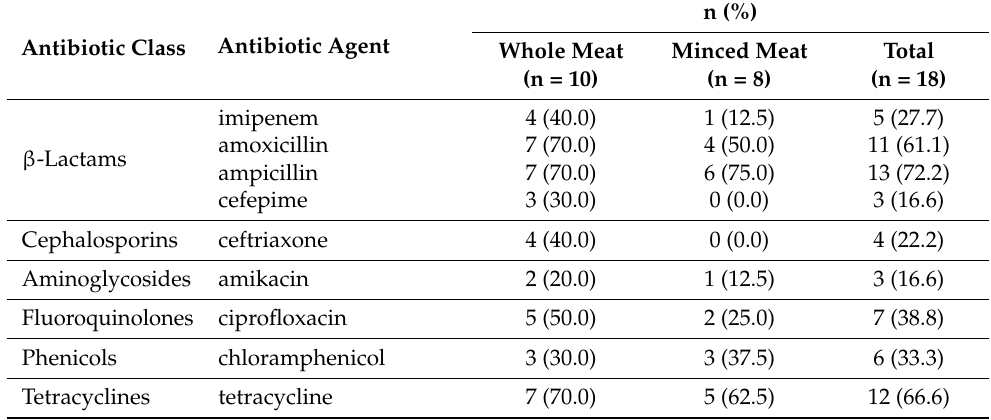
Table 1. Antibiotic resistance phenotype of C. perfringens isolated from the raw beef meat samples.